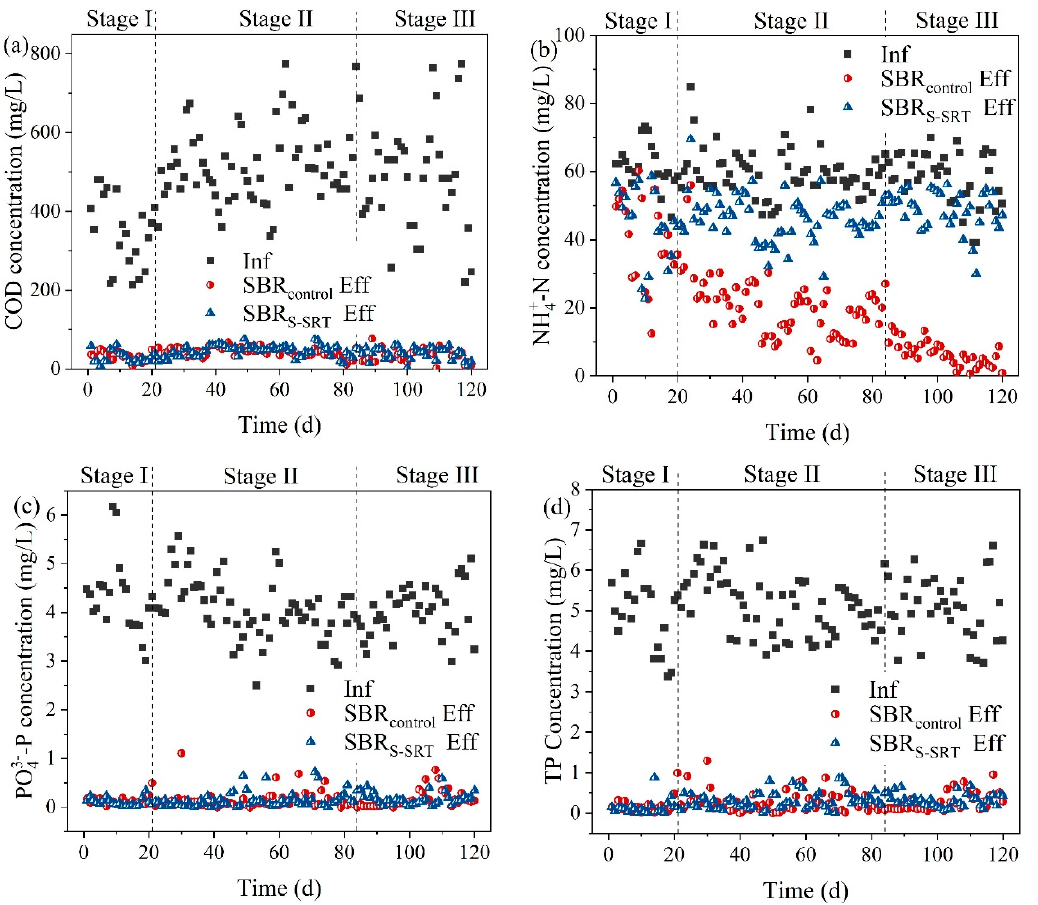
Figure 3. Performances of the two experimental SBRs on ( a ) COD, ( b ) NH 4+ -N, ( c ) PO 43− -P, and ( d ) TP removal.